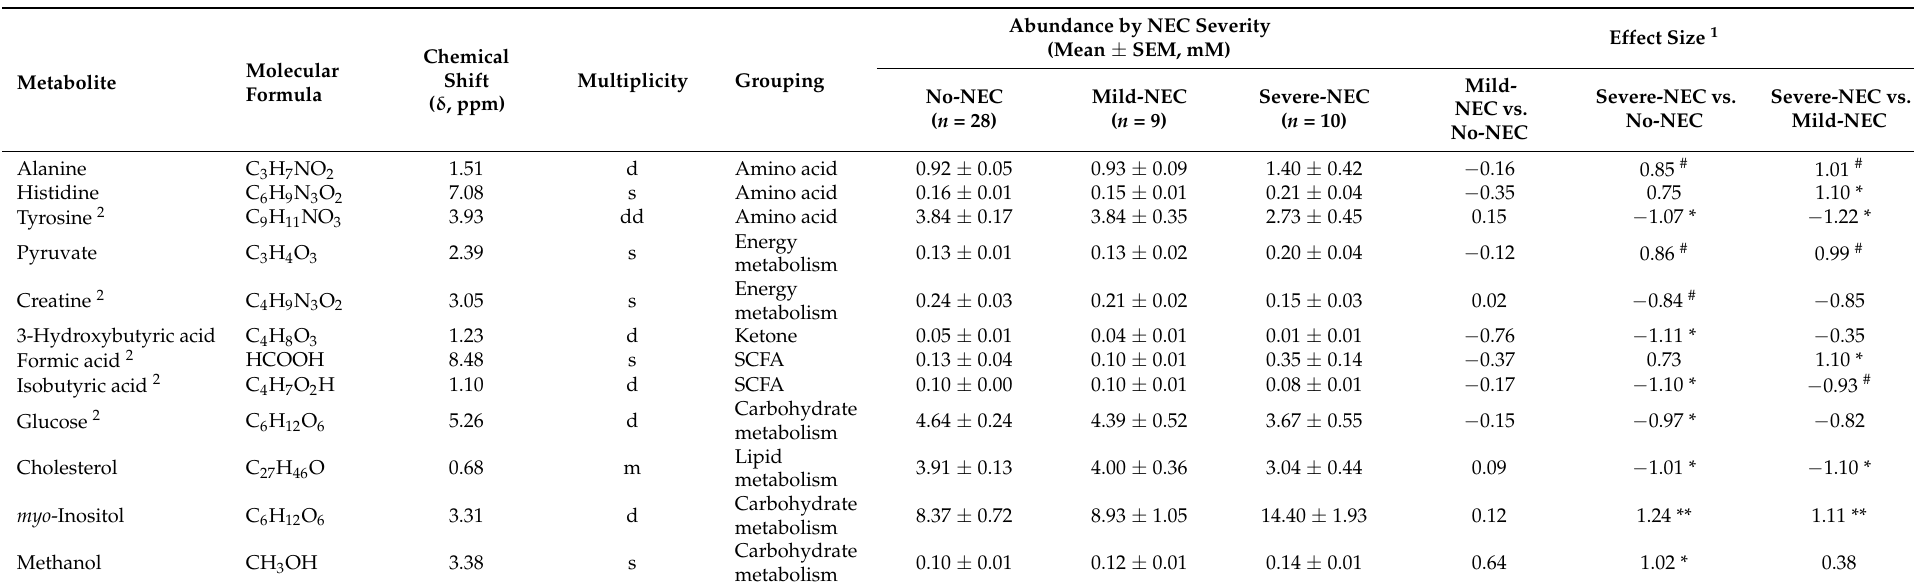
Table 1. Metabolites with differential abundance associated with NEC